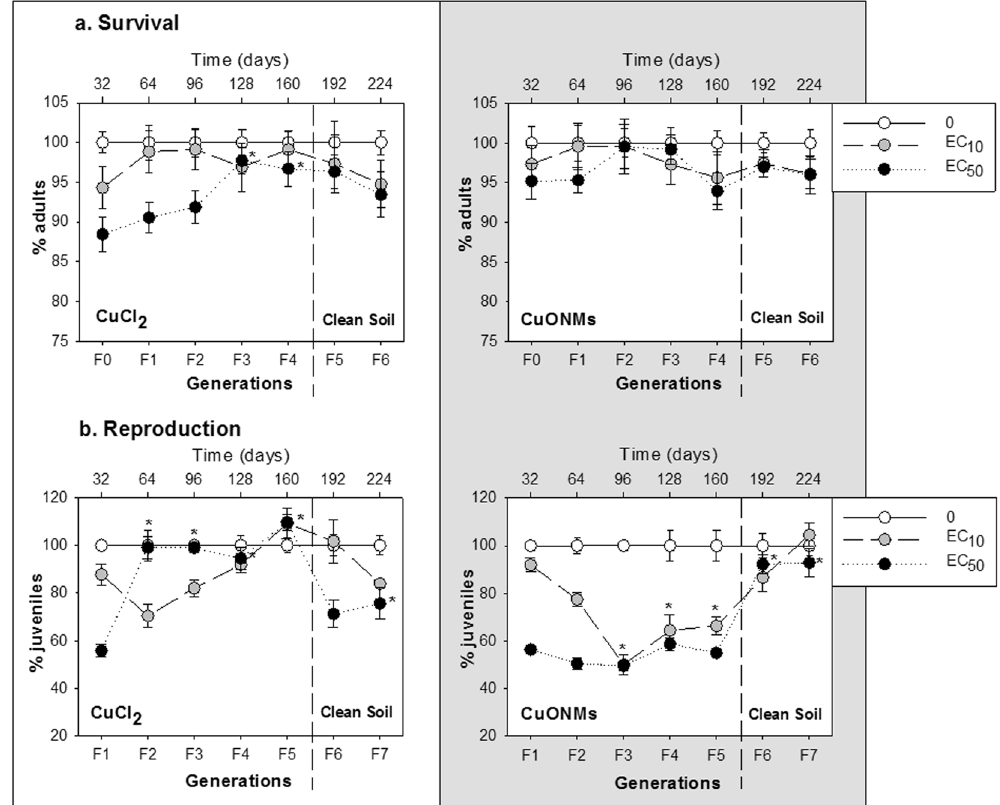
Figure 1. Results of the multigenerational test (MGt) for Enchytraeus crypticus . Exposure to the reproduction EC 10 and EC 50 of CuONMs and CuCl 2 (0-500-1400 mg Cu/kg and 0-20-180 mg Cu/kg DW soil, respectively) in LUFA 2.2 soil in terms of survival ( a ) and reproduction ( b ). All values are expressed as % normalized to the control, average ± standard error (Av ± SE). * p < 0.05 (Dunnets’ between parental generation (F0/F1) and